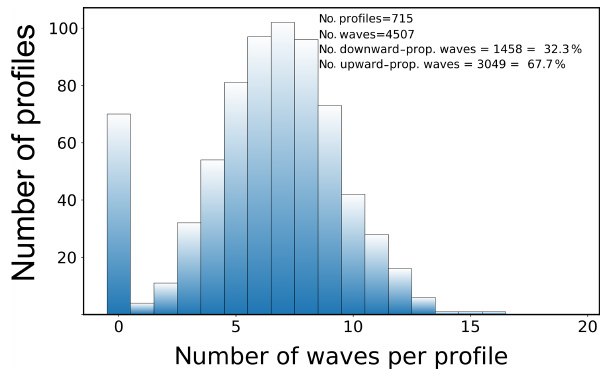
Figure 8. Total number of waves obtained per altitude profile for the entire data